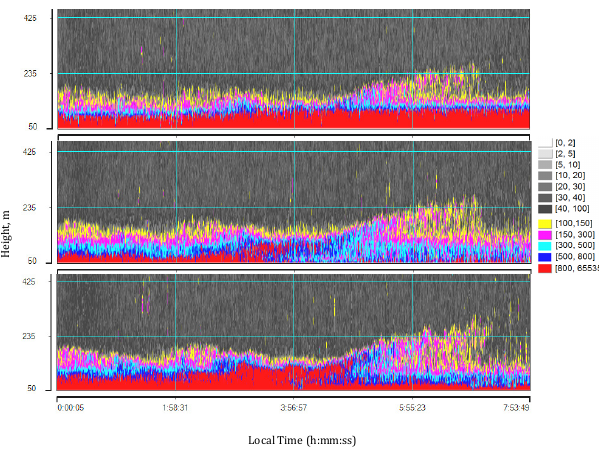
Fig. 3. Sodar echo for 30 July. Three components of the echo signal are shown: vertical (Channel 1, upper panel), North-South (Chan- nel 2, middle panel), and West-East (Channel 3, bottom panel).